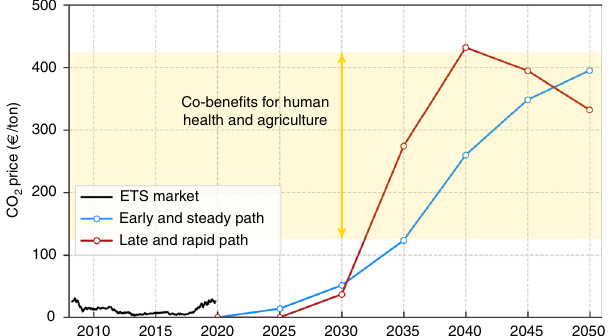
Fig. 5 Historical evolution of CO 2 price in the EU Emissions Trading System 68 and required CO 2 price obtained from the model throughout transition paths shown in Fig. 1. Co-bene fi ts of reducing CO 2 emissions in Europe due to avoided premature mortality, reduced lost workdays and increased crop yields are estimated in the range of 125 – 425 € /ton CO 2 43